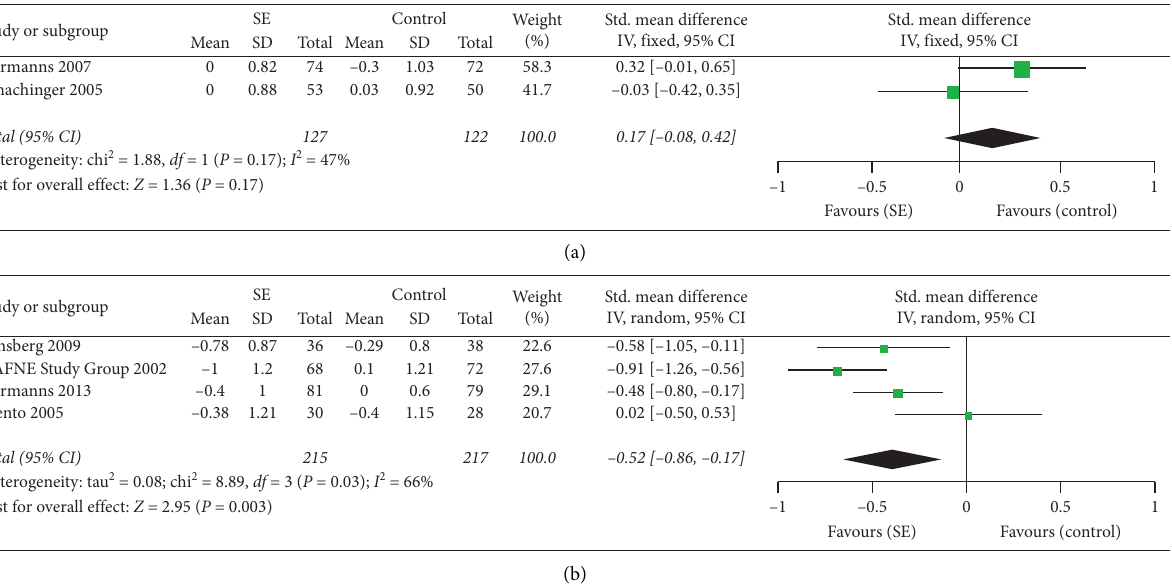
Figure 5: Forest plots showing the effect sizes of SE on HbA1c in adult patients with T1DM. (a) Baseline HbA1c < 7.5% and (b) baseline HbA1c ≥